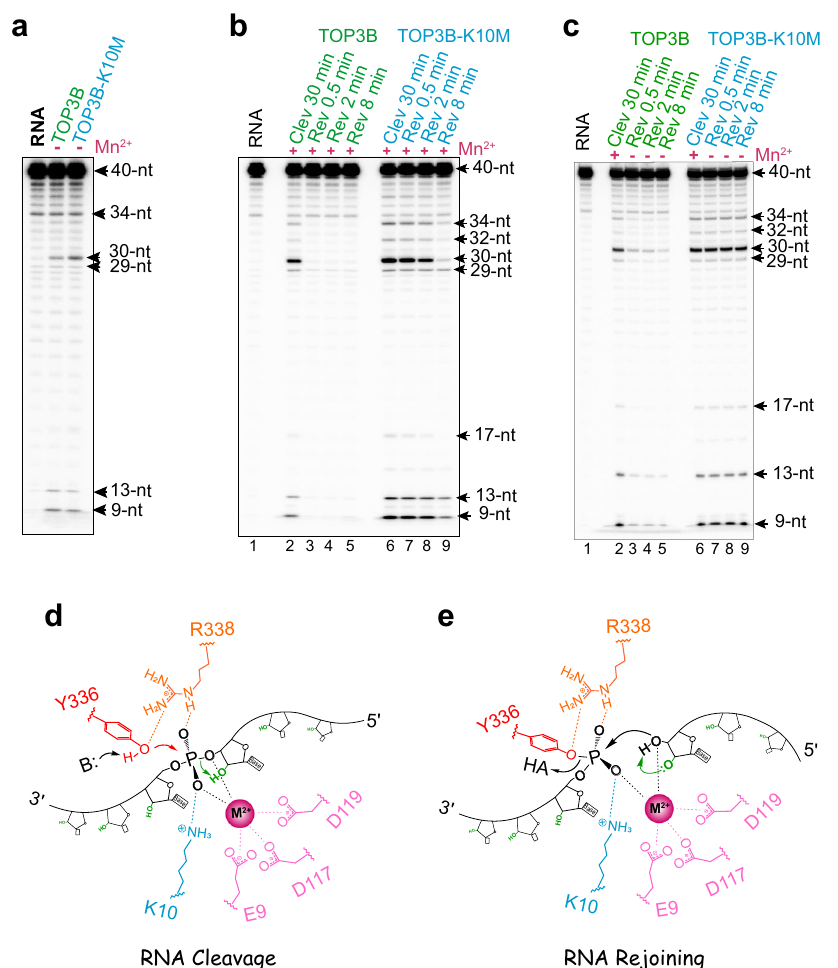
Fig. 3 | TOP3B K10 is dispensable for RNA cleavage and rejoining. a RNA clea- vagebyWTTOP3BandTOP3B-K10Mwithoutadditionofdivalentcations(andwith 10 μ M EDTA). b RNA cleavage and reversal in the presence of Mn 2+ (0.1mM) showing a slower RNA rejoining by TOP3B-K10M compared to the WT enzyme. c Lack of RNA cleavage reversal by TOP3B K10 in the absence of added metal ion. Initial cleavage reactions for WT TOP3B and TOP3B-K10M (lanes 2 & 6) were con- ducted in the presence of 0.1mM Mn 2+ and then followed by high-salt and EDTA addition ( fi nal EDTA concentration was adjusted to 50 μ M for reversal). Each RNA